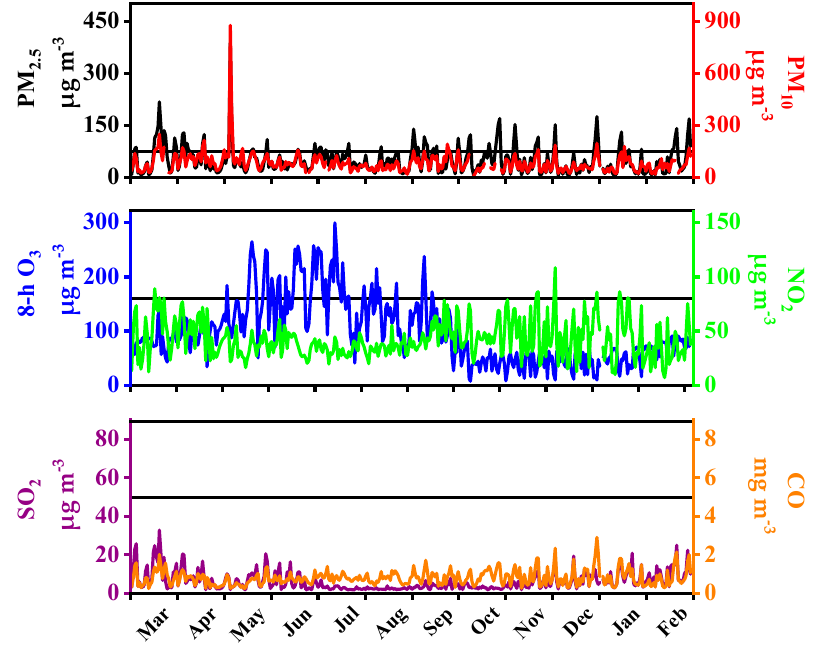
Figure 4. Daily average concentrations of PM 2.5 , PM 10 , CO, NO 2 , SO 2 , and 8-h O 3 in Beijing in 2017. The horizontal black lines represent the Grade II daily standards of Chinese Ambient Air Quality Standards (CAAQS) for PM 2.5 , PM 10 , NO 2 , and 8-h O 3 , the Grade I daily standards of CAAQS for SO 2 and CO.